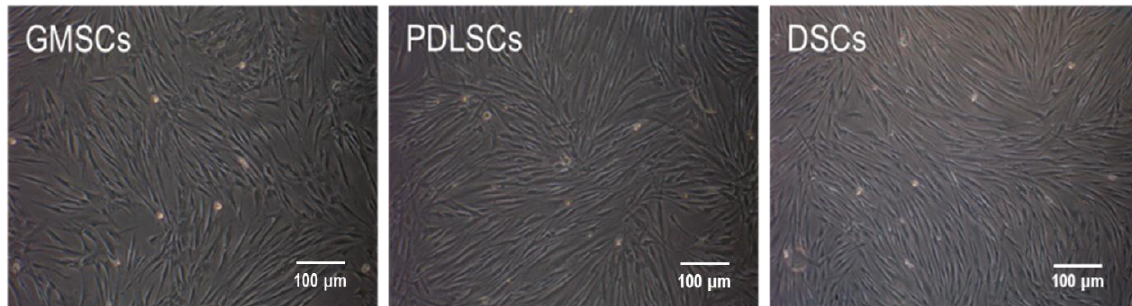
Figure 1. Morphology of the primary mesenchymal stem cells (MSCs) established from human gingiva, periodontal ligament and dermis (P3).